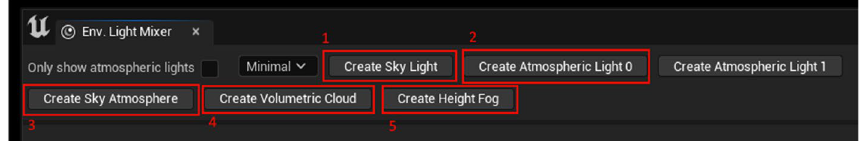
Fig. 2 Environment Light Mixer